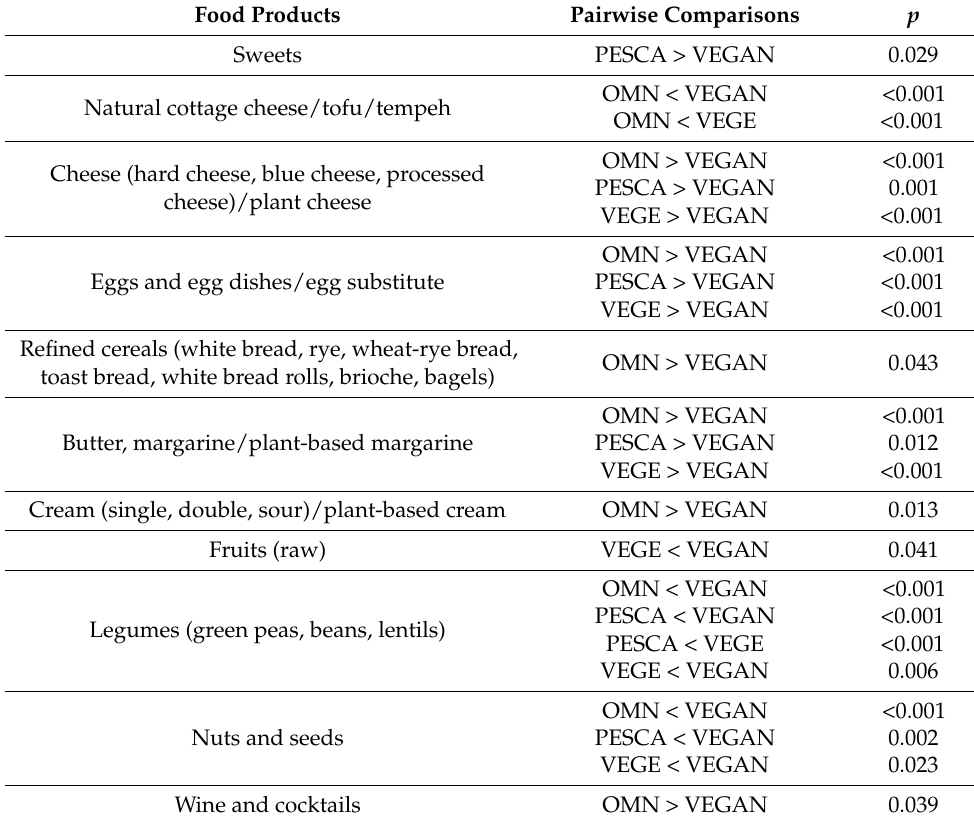
Table 6. Statistically significant differences in the frequency of consumption of food products between the studied